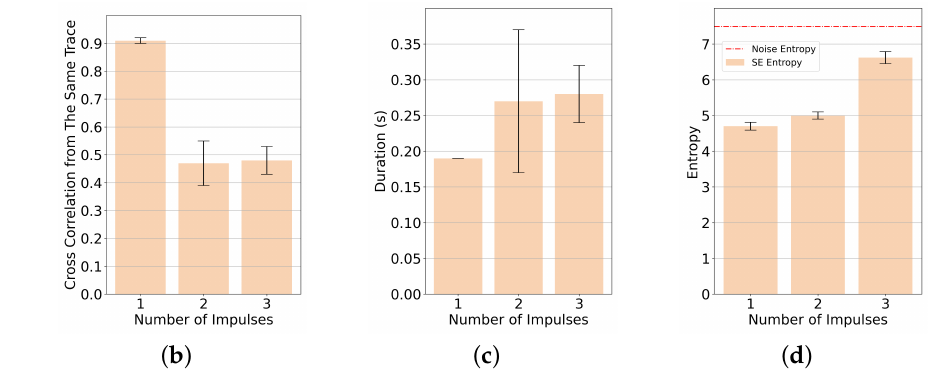
Figure 3. ( a – d ) are the results of the impulse load test experiment done in Pan et al.’s work [15]. This small ball hitting experiment treats ball hit impulse, an analogy to footstep event, as vibration source to study the predictive ability of each feature for pedestrian counting task. The x-axis represents the number of impulses. These figures only consider the 3 vibration source case, and can be interpreted in this way: the larger the difference among the height of the three bars, the more informative the corresponding feature. ( a ) Cross Correlation from Different Sensors. ( b ) Cross Correlation from The Same Trace. ( c ) Step Event Duration. ( d ) Step Event Signal Entropy.